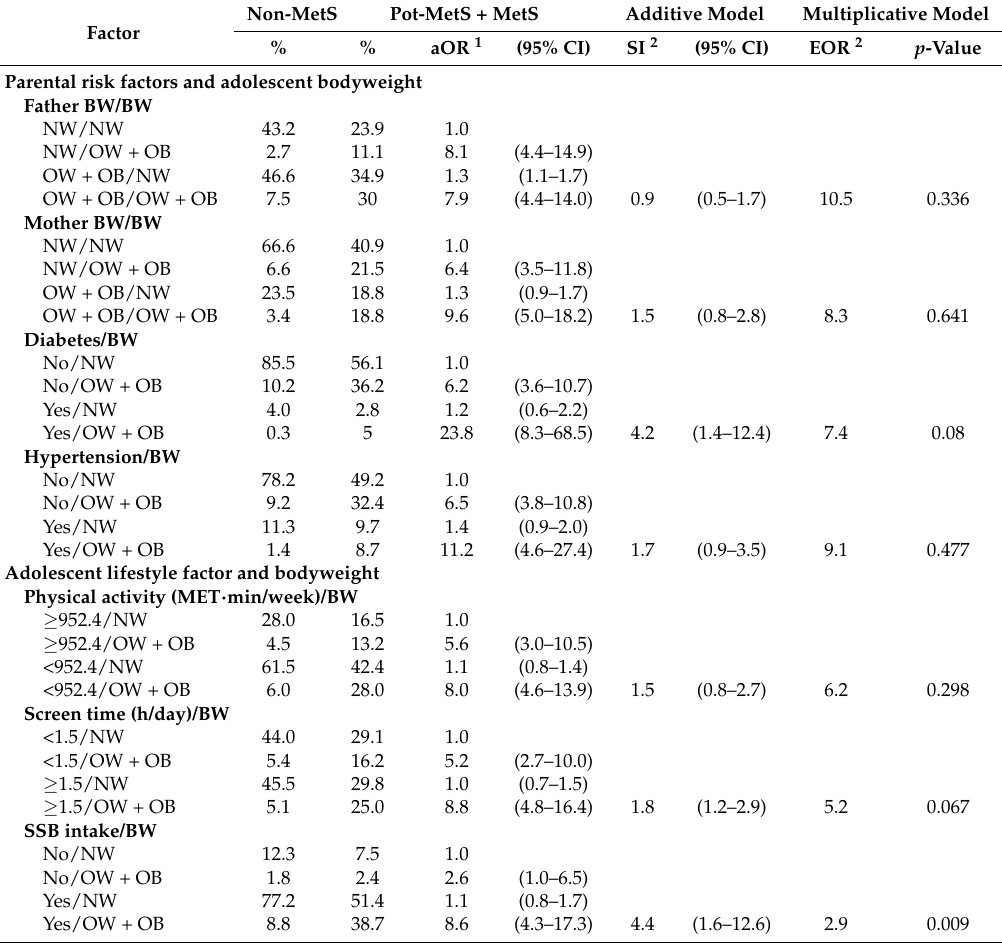
Table 5. Combined and interaction effects of parental risk factors and adolescent lifestyle factors on adolescent potential metabolic syndrome and metabolic